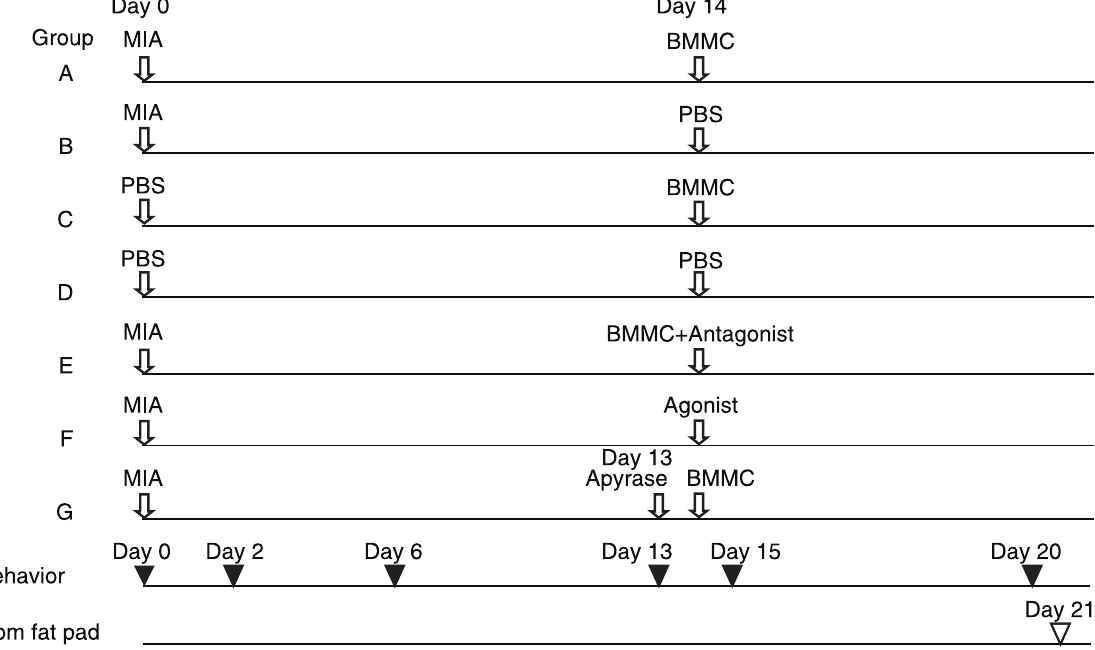
PLOS ONE | https://doi.org/10.1371/journal.pone.0252590 June 4,